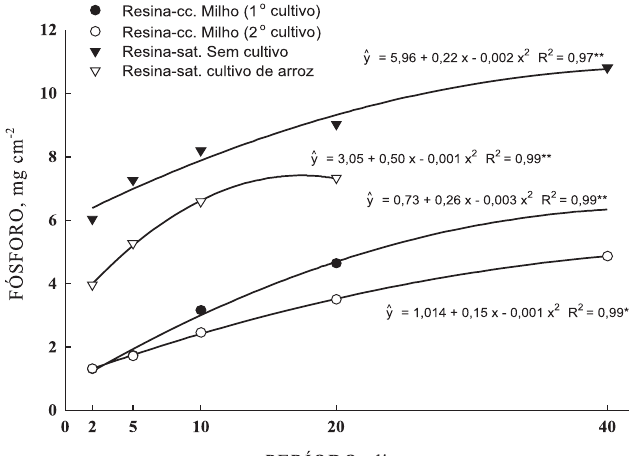
Figura 2. Relação entre o fósforo extraído pelas lâminas de resina enterradas e o período de sua permanência no solo (média de 5 solos com dois teores de fósforo), em solos do RS com diferentes características físicas, químicas, mineralógicas e de fertilidade. Resina-cc: resina em solo com umidade próxima à da capacidade de campo, resina-sat: resina em solo saturado com água. ** significativo (p <